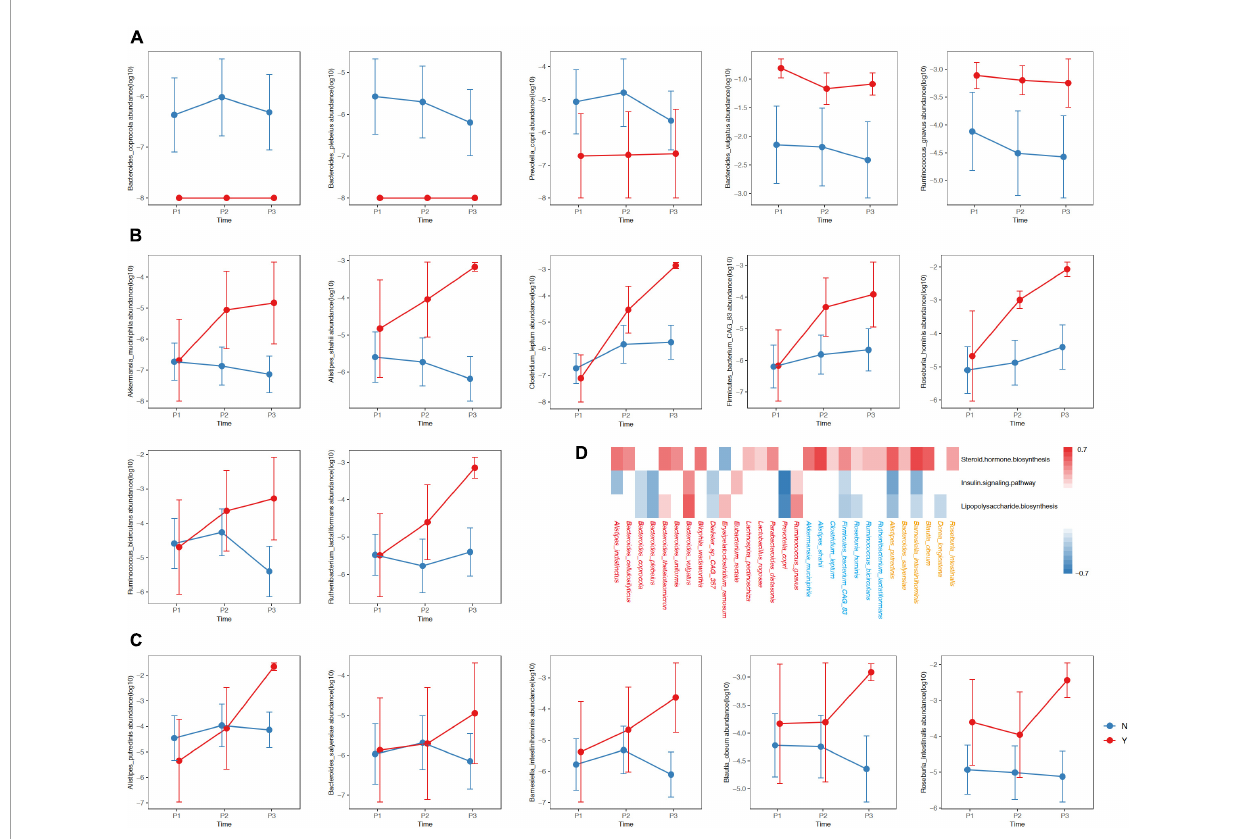
FIGURE4 Differences in the relative abundances of species between women with of without GDM at the three timepoints. The y-axis in Panels (A–C) represent log10 values of the relative abundances. The blue and red lines represent non-GDM and GDM groups, respectively. (D) The red, blue and orange colors of the species designate differing distributions among groups with respect to P1, P2, and P3, respectively. The colors in the heatmap reflect positive (red, r ≥ 0.3, adjusted P < 0.05) and negative (blue, r ≤ –0.3, adjusted P < 0.05) associations between the kegg3 function and the selected species. P1, P2, and P3 indicate the first, second, and third trimesters, respectively. The P- value was adjusted using the Benjamini–Hochberg